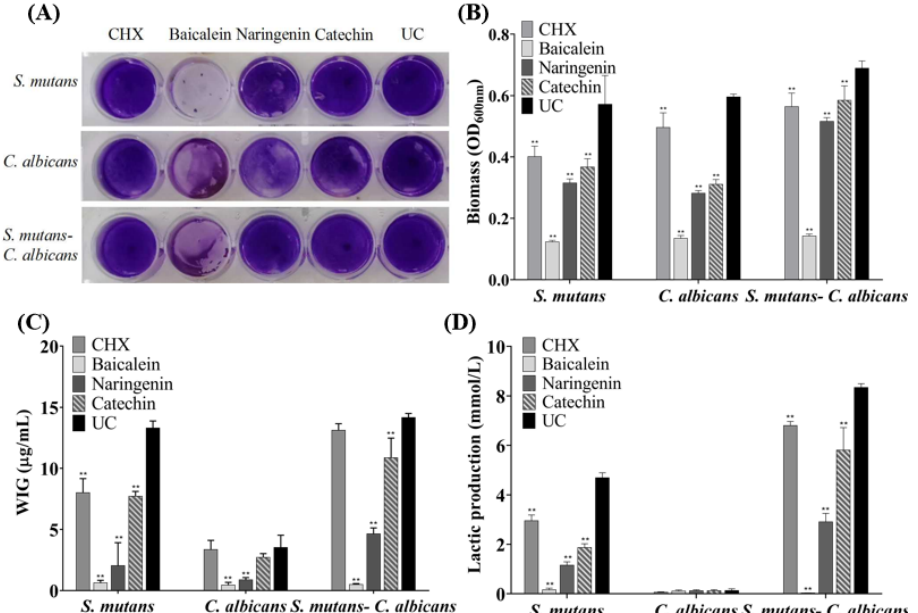
Figure 3. Biofilm formation with or without drugs: ( A ) a CV staining photograph of biofilms grown in a 24-well polystyrene microtiter plate; ( B ) quantification of biofilm biomass; ( C ) polysaccharide synthesis and ( D ) lactic acid production of the single-species and dual-species biofilms after flavonoids or CHX treatment. The values represent the mean ± sd for six independent experiments (mean ± sd, n = 6; ** p < 0.01).